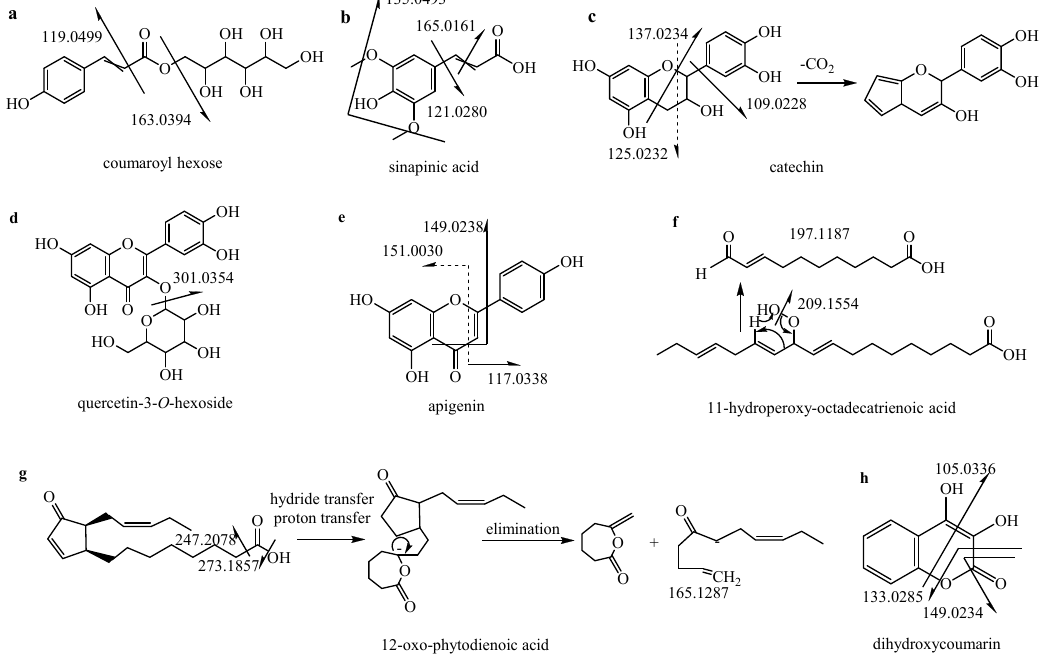
Figure 5. Possible fragmentation pattern of coumaroyl hexose ( a ), sinapinic acid ( b ), catechin ( c ), quercetin-3-O-hexoside ( d ), apigenin ( e ), 11-hydroperoxy octadecatrienoic acid ( f ), 12-oxo-phytodienoic acid ( g ), and dihydroxycoumarin ( h ).